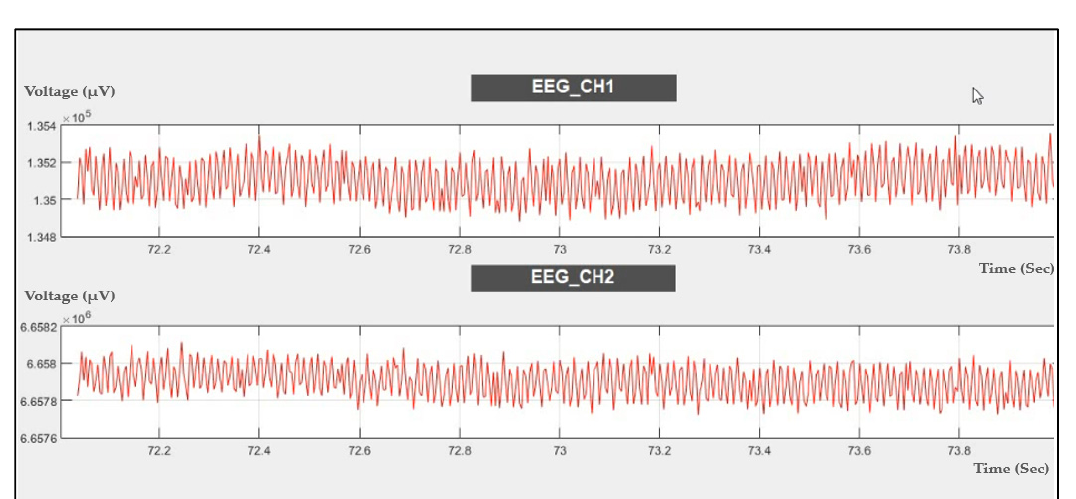
Figure 12. Channel 1 input-referred noise.